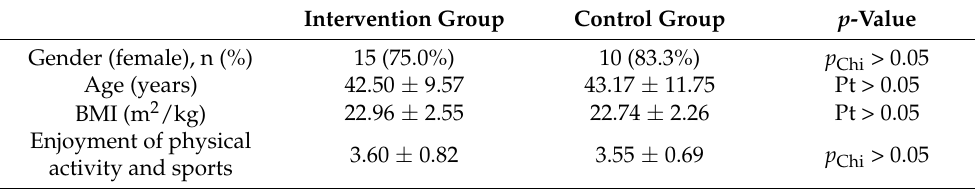
Table 2. Demographic data of the participants of the intervention and control groups at week 0. Intervention Group Control Group